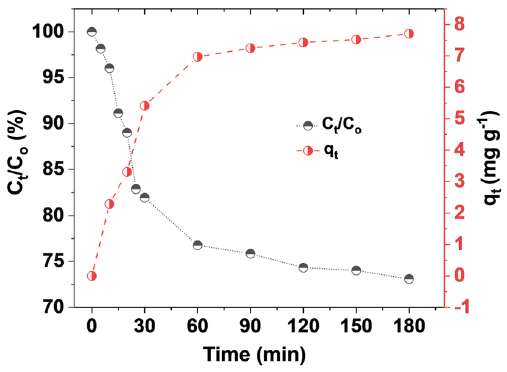
Fig. 8 The effect of contact time for adsorption of RhB (30 mg L −1 ) onto L-Asp capped Fe 3 O 4 (1 mg mL −1 ) at pH 7 and 25